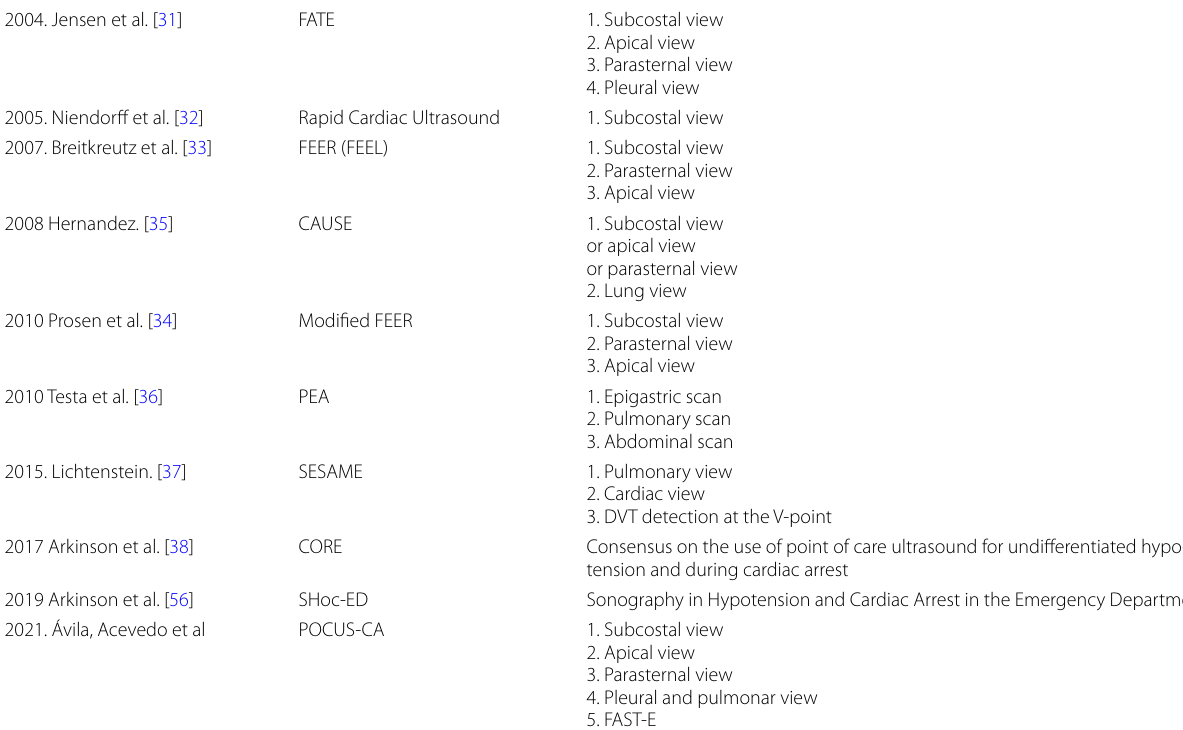
Table 3 Ultrasound protocols in cardiorespiratory